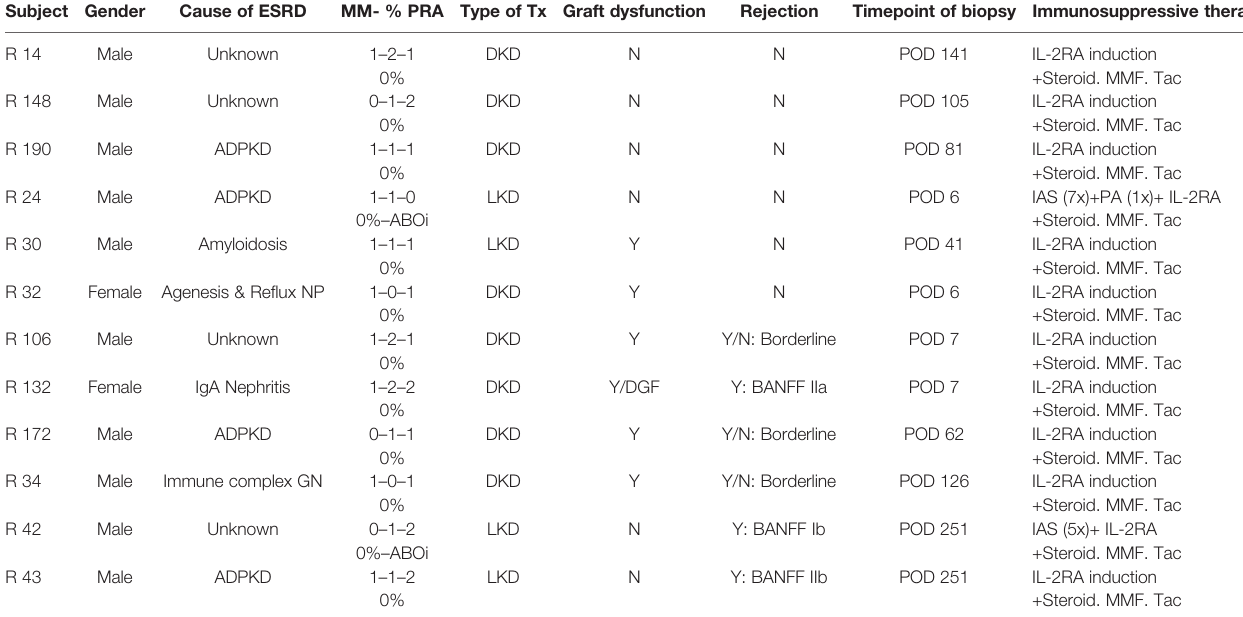
TABLE 1 | Patient characteristics of selected individuals for TCR beta